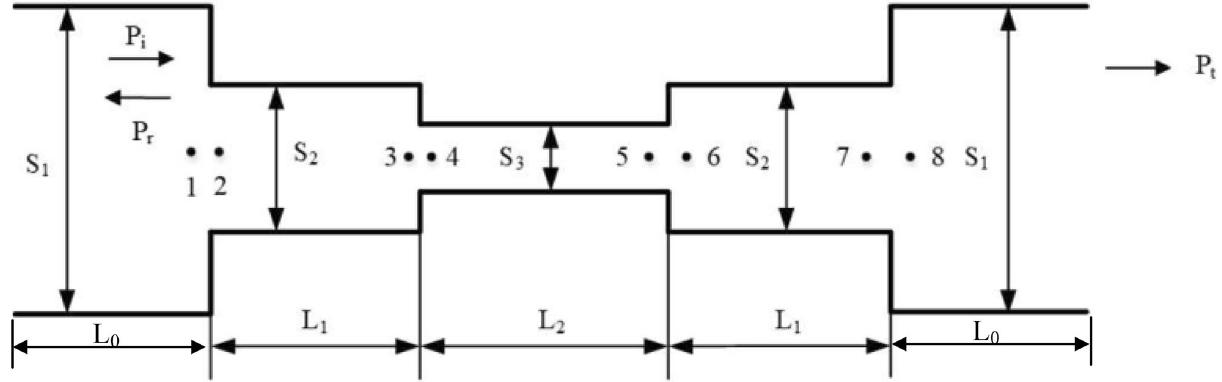
Figure 1. A labyrinthine metamaterial unit cell with unpacked equivalent straight